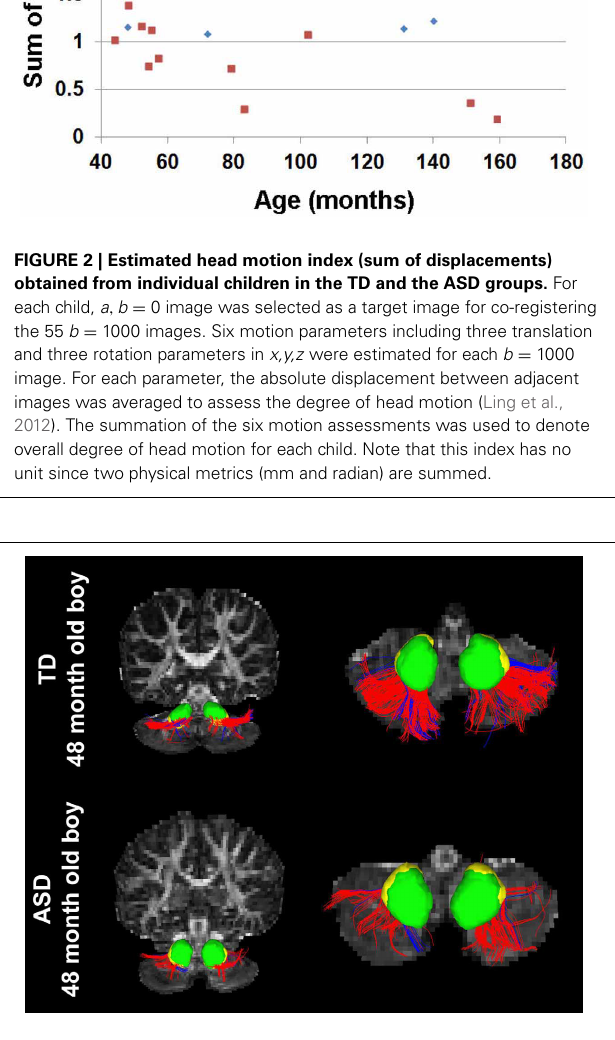
FIGURE 3 | Streamlines connecting the posterior-lateral cerebellar cortex with the DDN (red) and the VDN (blue) in two age-matched boys, (top) TD and (bottom) ASD. It is visually apparent that the boy with ASD shows significantly reduced streamline number and volume compared to the TD child; total streamline volume of both sides = 13985 and 8933mm 3 for the TD child and the child with ASD, respectively.